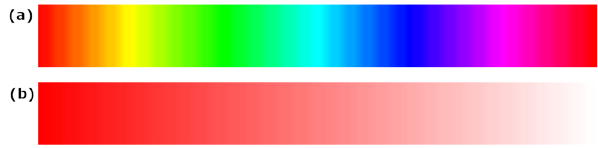
Fig. 2. (a) Variation in the hue of a colour; (b) variation in the saturation of a